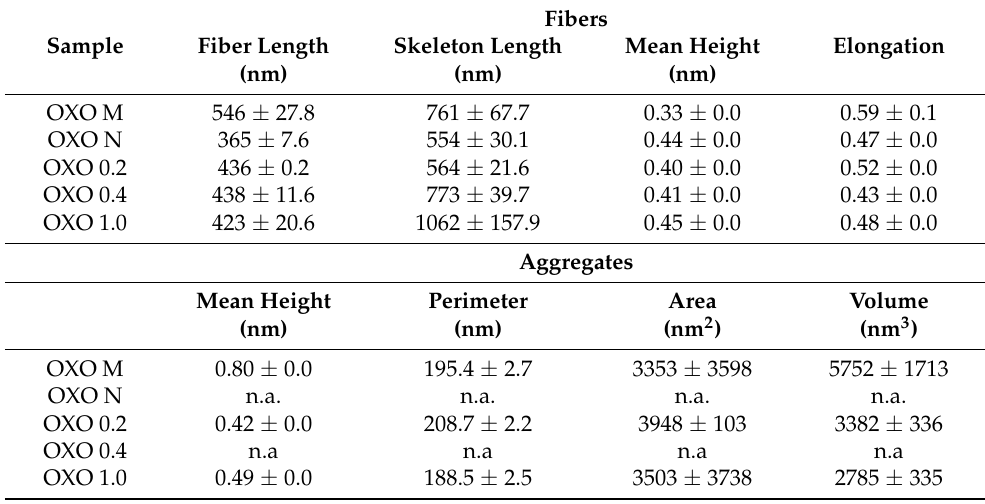
Table A1. Polysaccharides’ fiber and aggregates parameters as calculated by the imaging